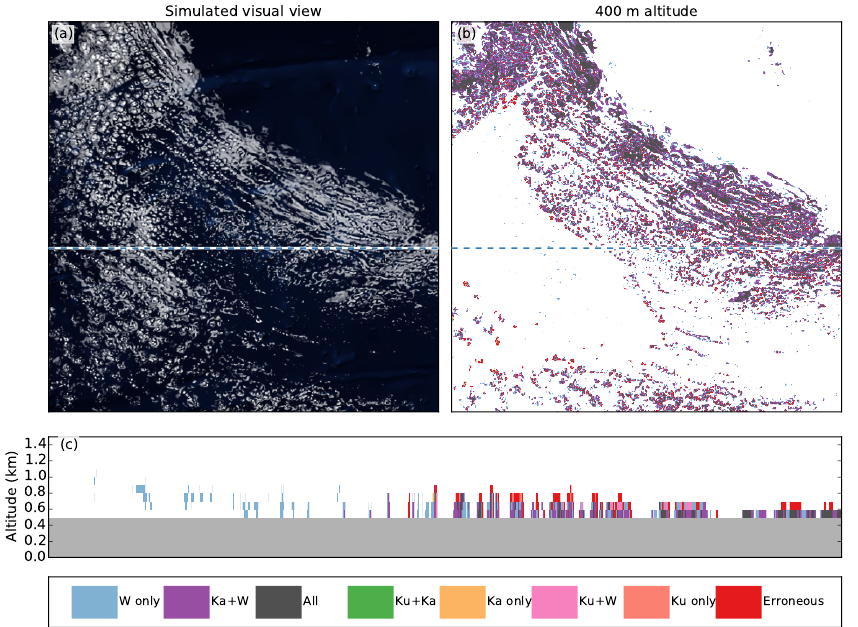
Figure 12. As in Fig. 6, but for the maritime stratocumulus (Sect. 5.5; MSC in Fig. 3), and with the levels restricted to the 400m altitude.